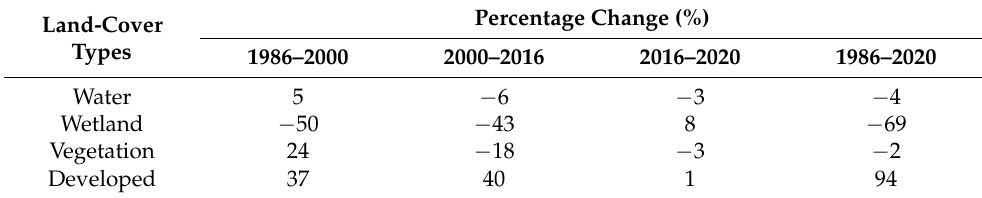
Figure 5. Graphical representation of a 34-year LULC change in the study area between ( a ) 1986 and ( b ) 2020. Table 4. Pair-wise percentage change for the year of study.